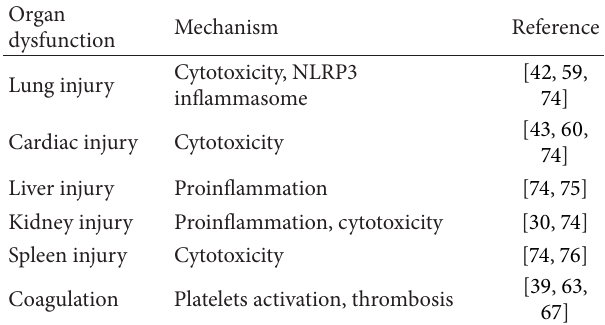
Table 1: Sepsis-associated organ dysfunction induced by extracellu- lar